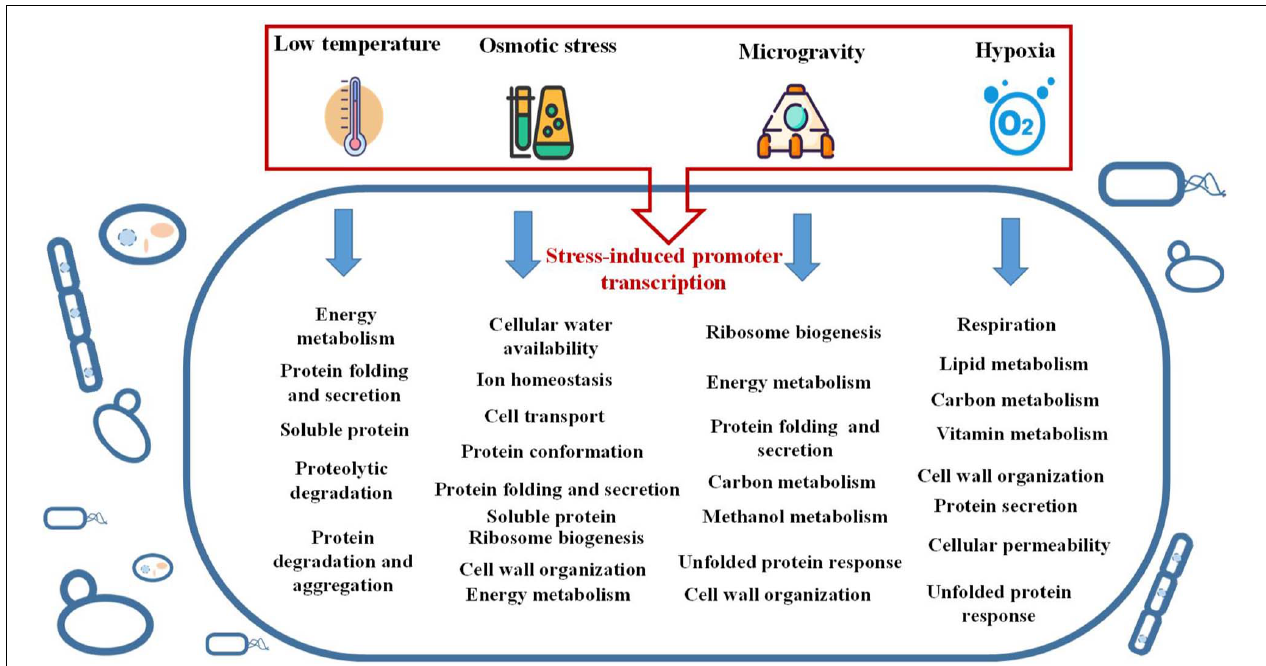
FIGURE 3 | The cell activities interfered by different environmental